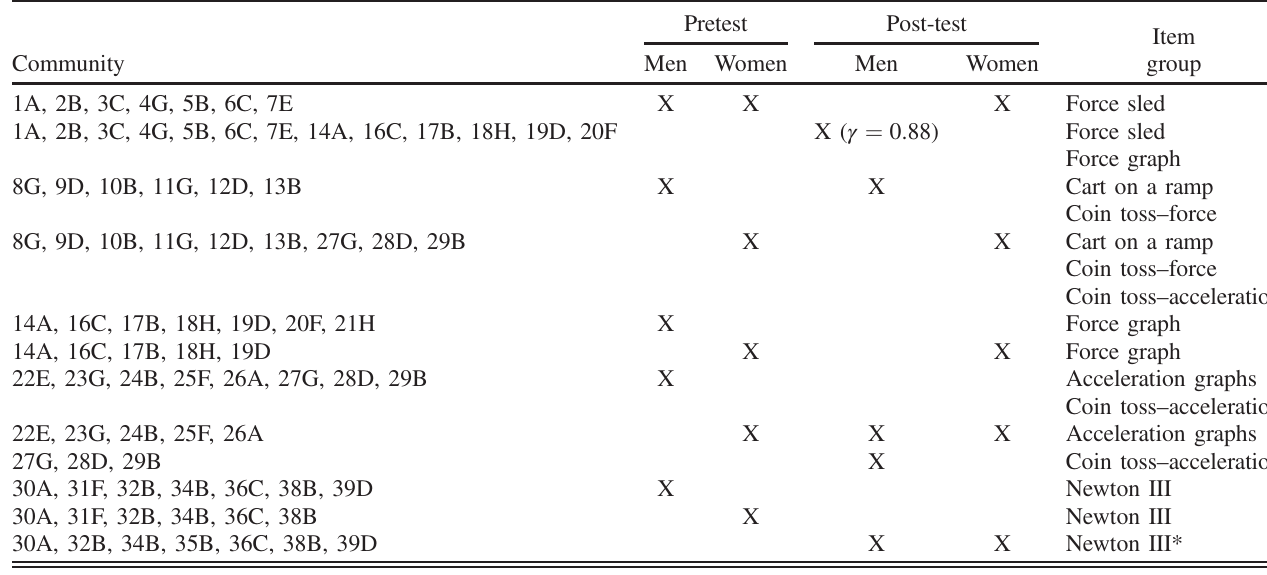
TABLE I. Communities identified in the pretest and post-test incorrect answers at r > 0 . 2 and community fraction, C > 0 . 8 . Only nodes selected by 20% of the students are included. The number in parentheses is the intracommunity density γ for communities where the intracommunity density is not 1. Newton III* denotes that this community does not contain 31F.